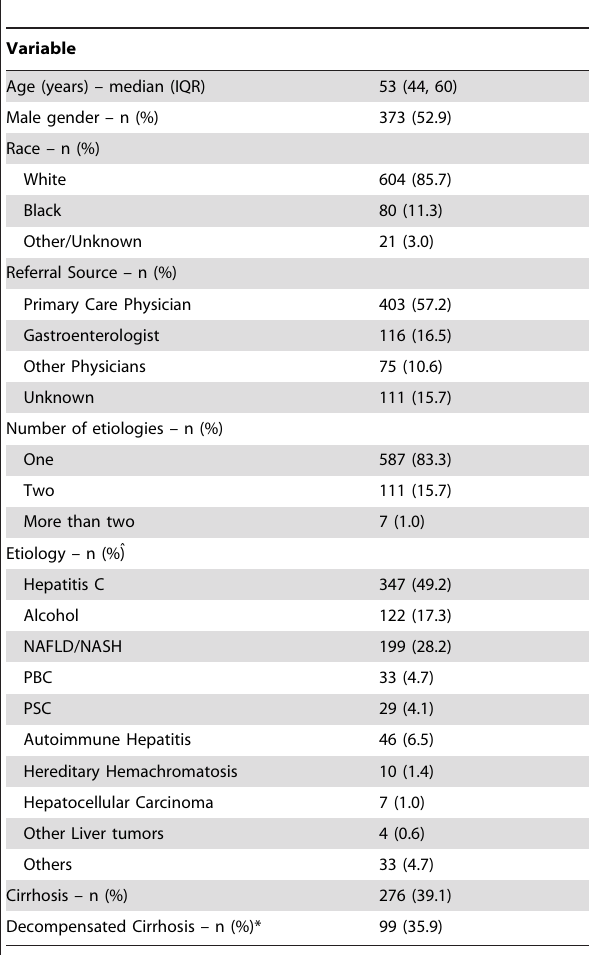
Table 1. Demographics, etiology and disease status of the study population (N